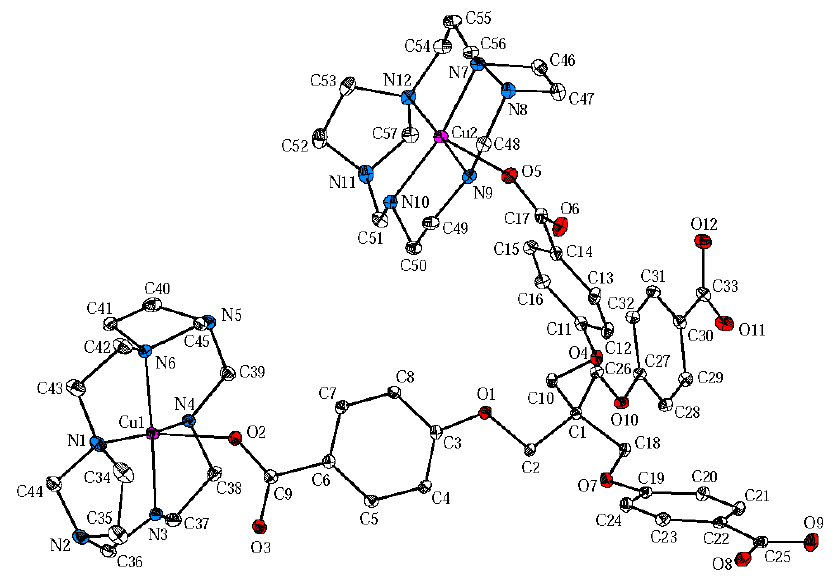
Figure 1. ORTEP representation at 20% probability and atom numbering scheme for 3 •11H